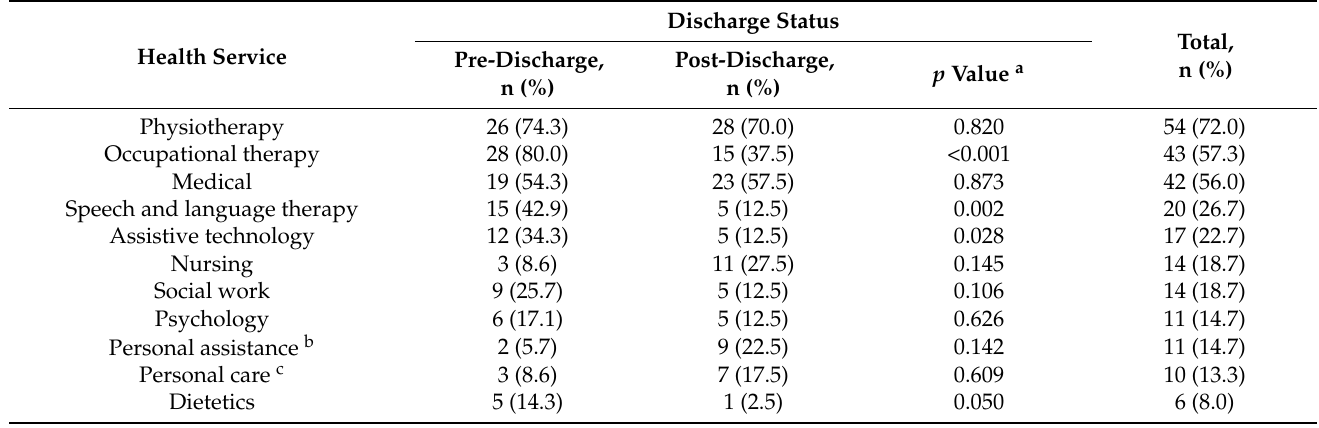
Table 4. Description of services currently accessed by young people (n =